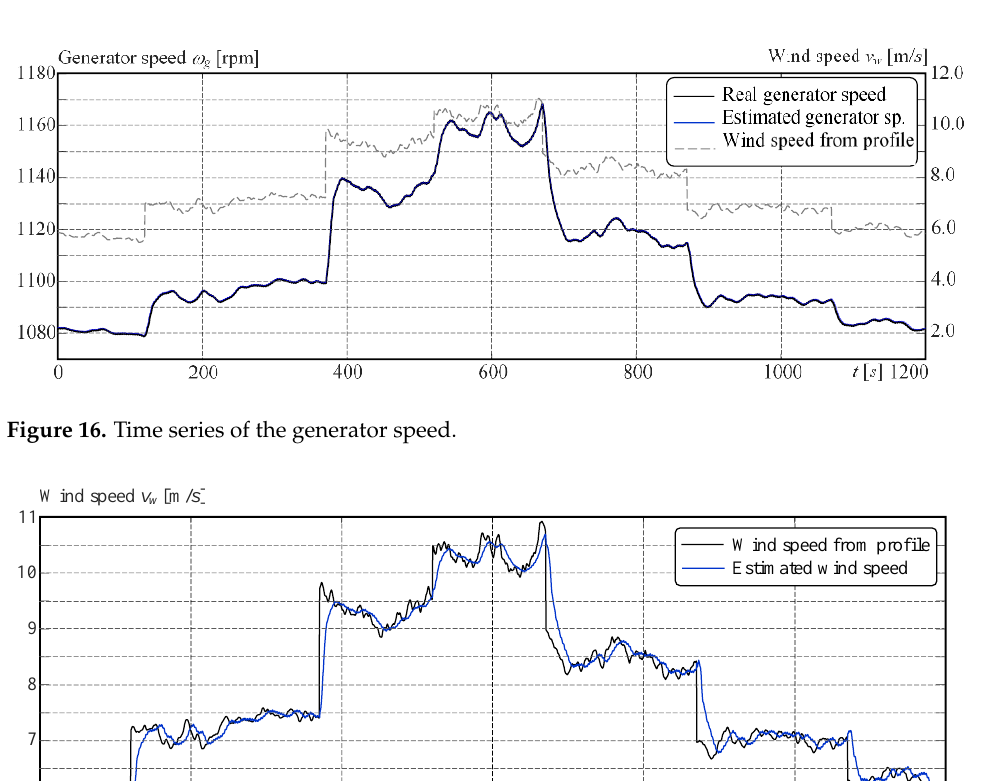
14 of 19 Table 4. Quantitative evaluation of the model and observer performance. Parameter